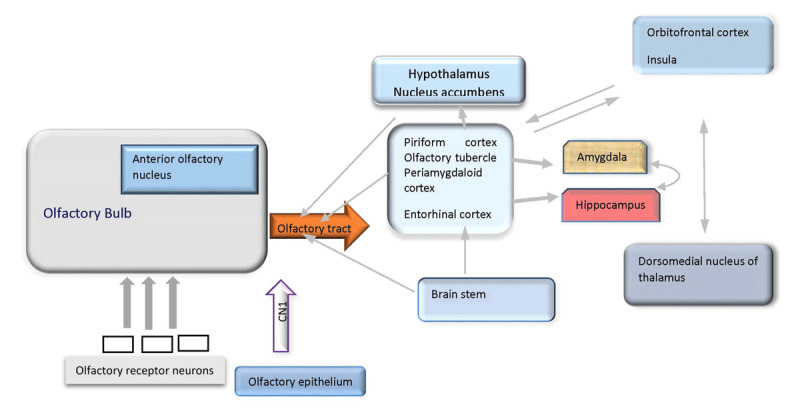
Neuroanatomy of Olfactory System.